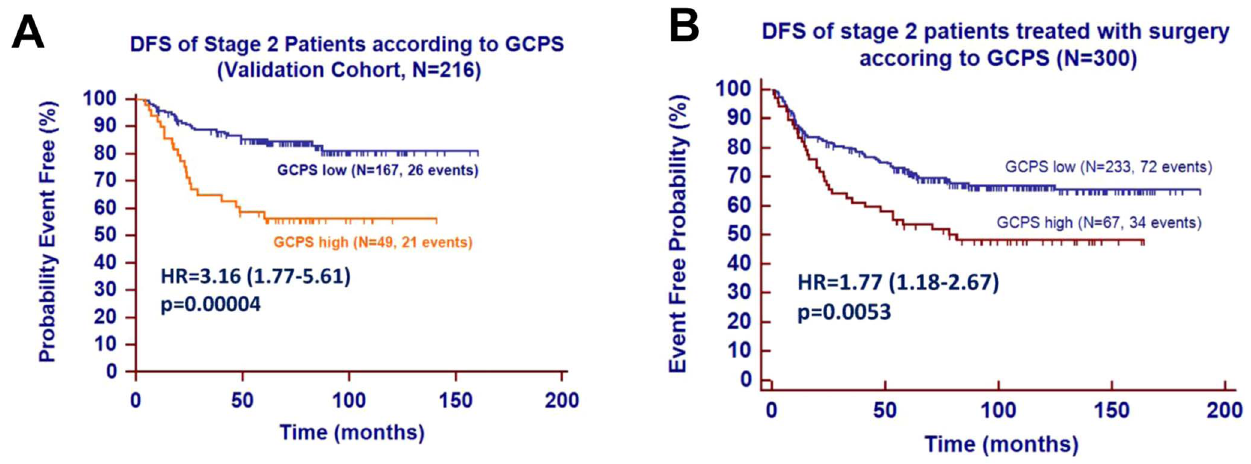
Table 2. Multivariate Cox regression analysis results on the validation set (N=